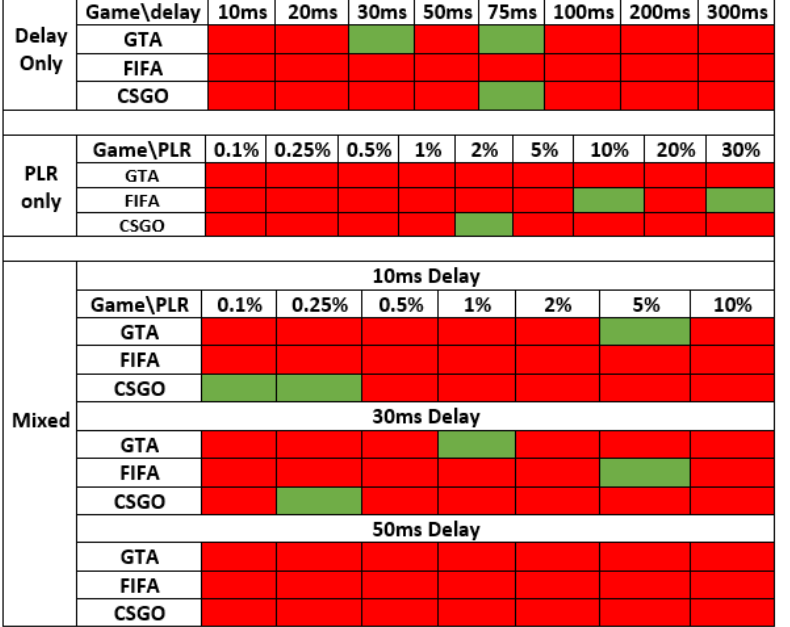
Figure 11. Wilcoxon Signed-Rank tests results for each GuT at different QoS parameters. Red boxes show that the Null hypothesis is accepted, and Green boxes show that the Null hypothesis is